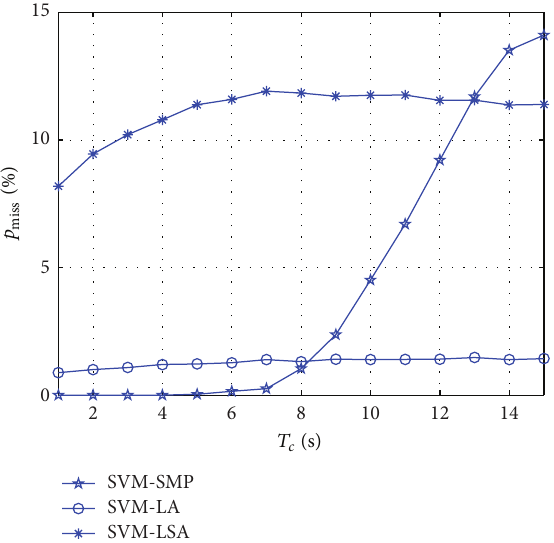
for CUs versus 𝑇 𝑐 miss